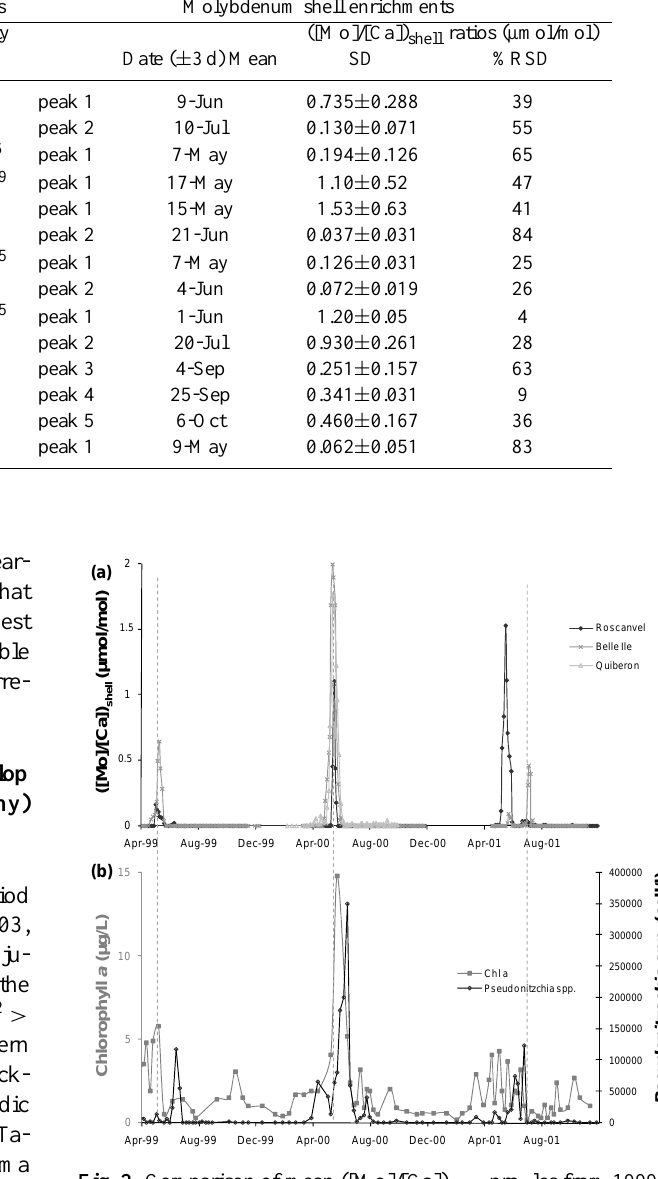
Fig. 2. Comparison of mean ([Mo]/[Ca]) shell profiles from 1999 to 2001 (a) from 3 sites in Brittany, France to examine the occurrence and intensity of ([Mo]/[Ca]) shell peak: Roscanvel (black lines), Belle Ile (dark grey lines), Quiberon (light grey lines); and (b) with the phytoplankton concentration (total biomass with chlorophyll a , and specific diatom concentration with Pseudonitzschia spp.) monitored at Quiberon station, close to the sampling zone named Quiberon, and the closest monitoring station to the Belle Ile sampling zone. Mean ([Mo]/[Ca]) shell profiles is the average of 3 shell profiles per year (except in 1999 and 2000 for Belle Ile, n=4).